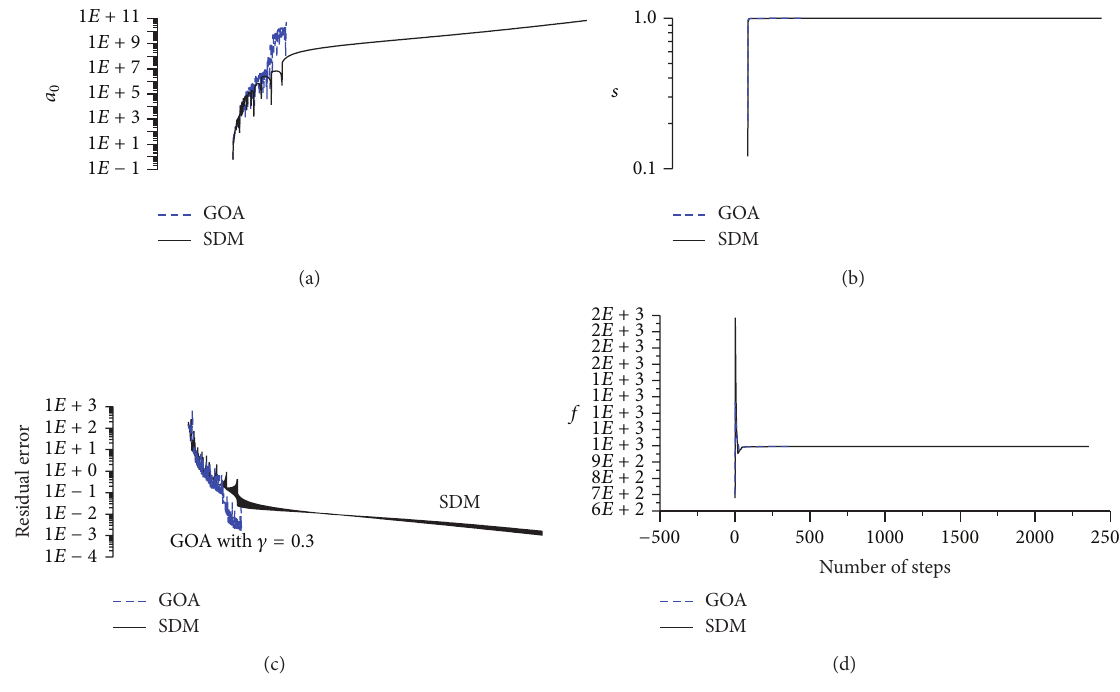
Figure 7: For the maximum area under a given curve comparing (a) 𝑎 0 , (b) 𝑠 , (c) residual error, and (d) 𝑓 obtained by the SDM and GOA.